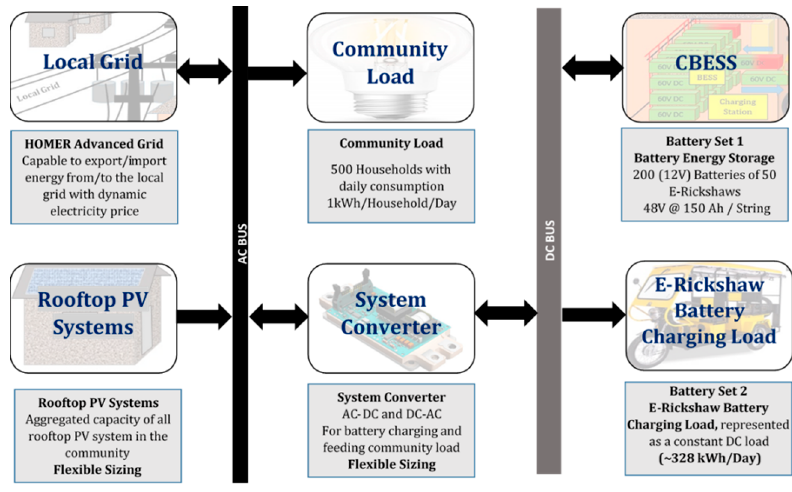
Figure 6. Architecture of the system for HOMER Pro software (author’s illustration).